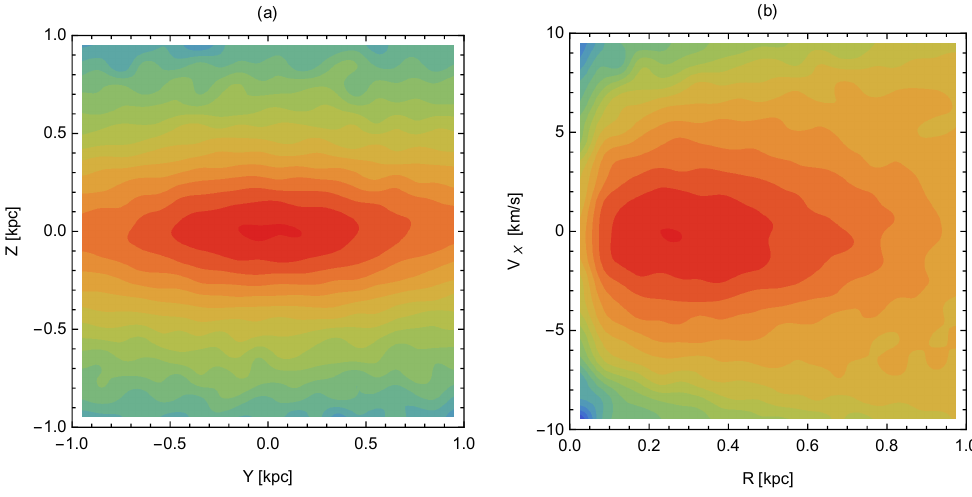
Figure 5. Observed properties of the simulated dwarf at the time of disruption. ( a ) The surface density distribution of the stars as would be seen along the X axis of the simulation box; ( b ) The phase-space diagram showing the distribution of stars in the velocity-radius plane, V X − R